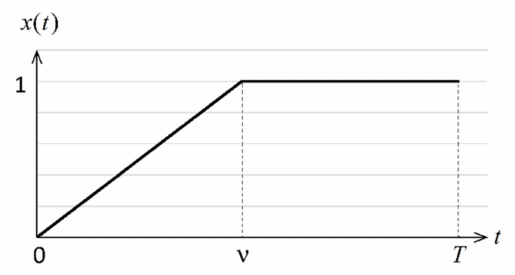
Figure 1. The form of the input signal